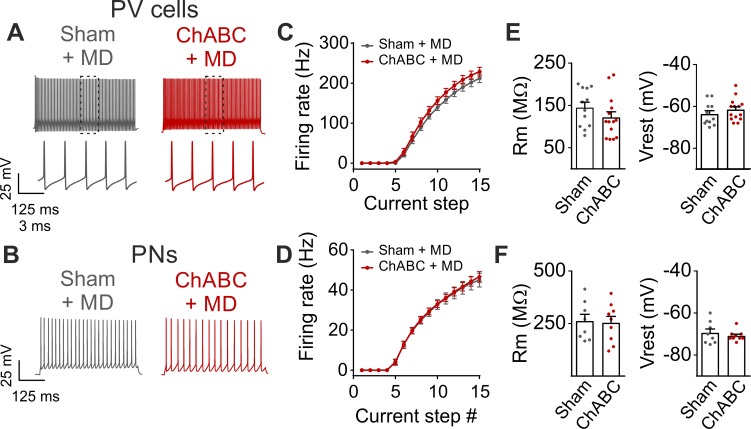
Monocular deprivation does not affect firing dynamics and passive properties following PNN removal in adult animals.(A–B) Characteristic firing of PV cells and PNs respectively, in response to depolarizing current injections, in control condition (Sham, grey) and in ChABC-treated animals (ChABC, red). Inset in a shows the firing behavior of PV cells at an expanded time scale. (C–D) Average f-i curves of PV cells (C) and PNs (D). (E–F) Passive properties of PV cells (E) and PNs (F). PV = parvalbumin positive interneuron. PN = principal neuron. MD = monocular deprivation. All experiments were performed in sensory deprived animals (MD). All values are in Table S1.
10.7554/eLife.41520.011Figure 2—figure supplement 3—source data 1.Source data for Figure 2—figure supplement 3C–F.